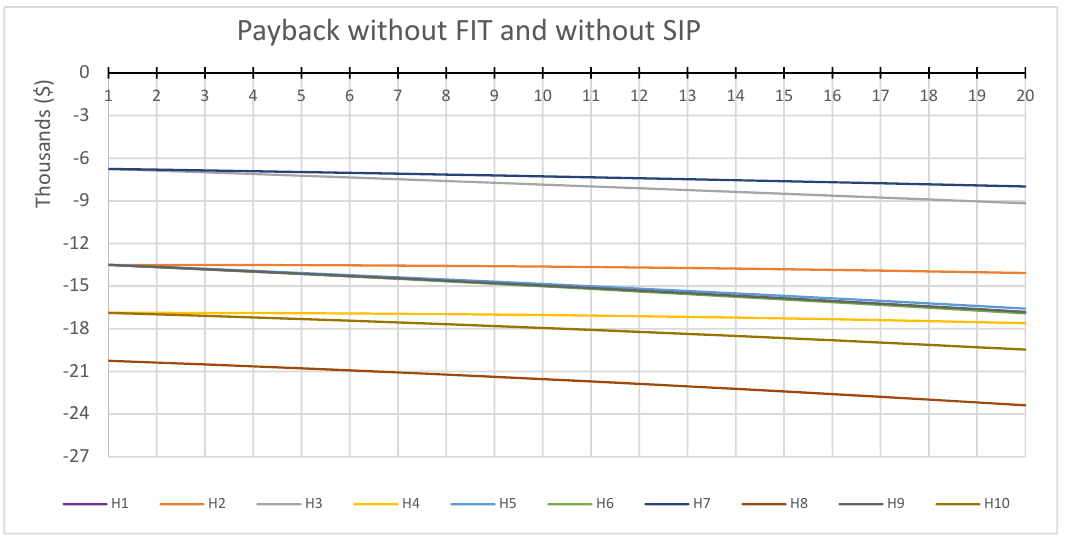
Figure 10. Economic model results demonstrate the payback time for the rooftop PV systems without FIT and SIP for houses H1:H10.